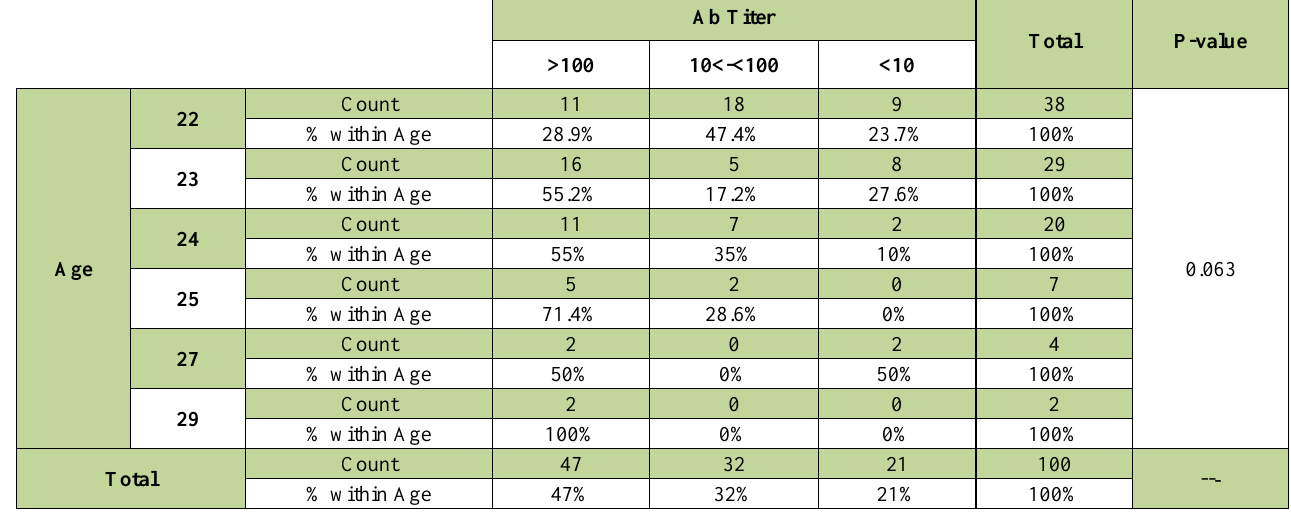
Table 8. Analysis of the relationship between the anti-hepatitis B titration in individuals with the age of participants.